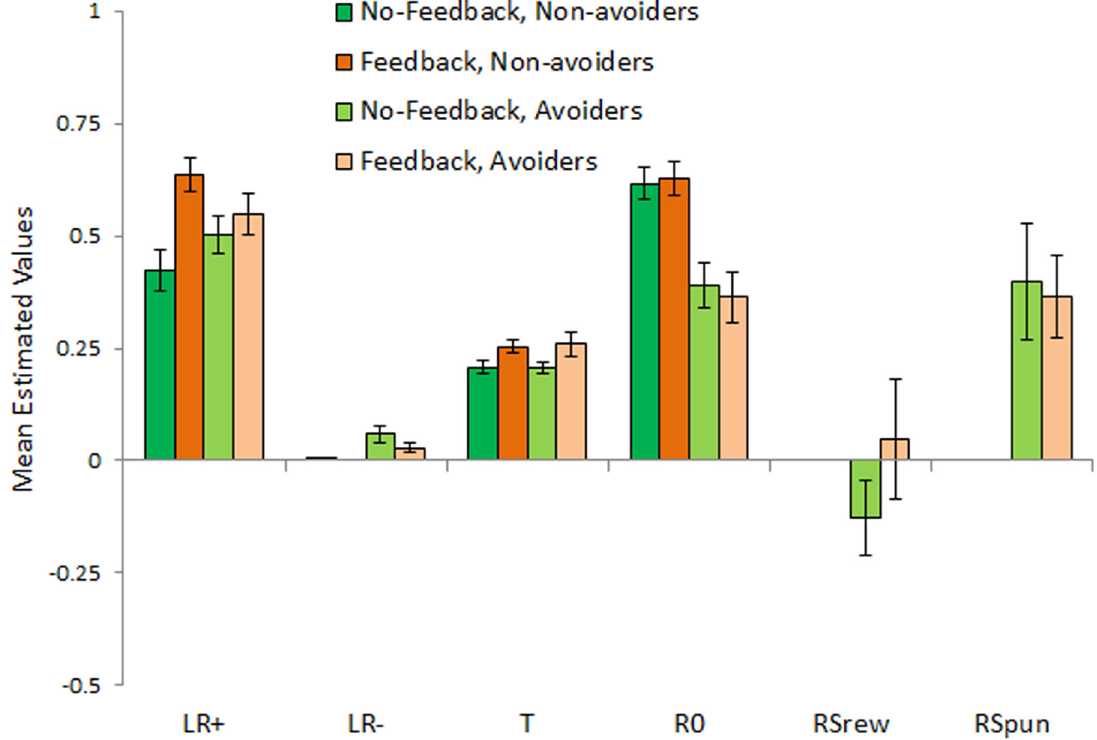
Fig 5. Results obtained with the six-parameter model. Overall, subjects in the no-feedback condition had larger estimated values of LR+ , indicating that they adjusted their behavior faster following better-than-expected feedback, compared to subjects in the feedback condition. In addition, estimated values of R0 were significantly lower, and those of LR- were significantly higher, in subjects who made at least one avoidance response ( “ avoiders ” ), compared to subjects who made no avoidance responses at all ( “ non-avoiders ” ), regardless of experimental condition. (Note that estimated values for RSrew and RSpun are undefined for non-avoiders, who never experienced these types of